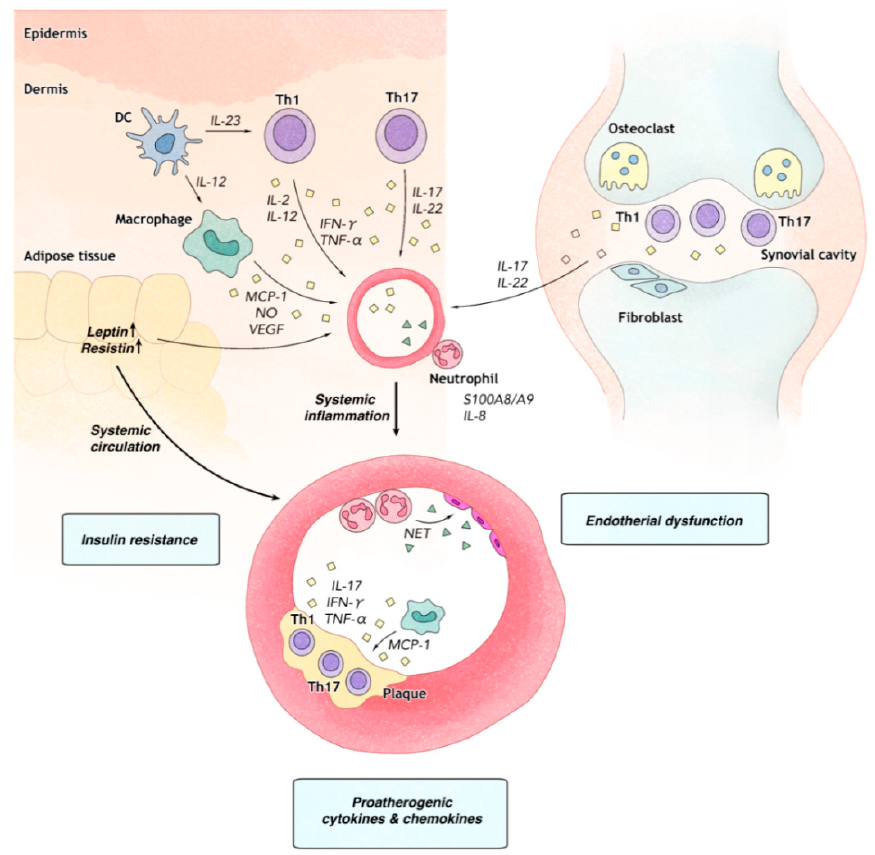
Figure 1. Psoriasis, psoriatic arthritis, and atherosclerosis have the common underlying pathomechanisms. In psoriatic plaque ( left ) and synovial cavity with psoriatic arthritis ( right ), myeloid dendritic cells (DC) stimulate naïve T-cells to di ff erentiate into type 1 helper T (Th1) and type 17 helper T (Th17) cell subtypes. Th1 cells secrete tumor necrosis factor- α (TNF- α ) and interferon gamma (IFN- γ ), leading to keratinocyte and synovial fibroblast activation. Th17 cells secrete IL-17 and IL-22, which promote proliferation of keratinocytes and synovial fibroblasts and angiogenesis. Macrophages cooperates with Th1- and Th17-mediated inflammation by releasing monocyte chemoattractant protein (MCP-1), nitric oxide (NO), and vascular endothelial growth factor (VEGF), which further contribute to angiogenesis. Neutrophil-derived S100A8 / A9 and IL-8 accelerates vascular inflammation. In atherosclerotic plaque ( bottom ), Th1 cells secrete TNF- α and IFN- γ , leading to endothelial activation and promote atherosclerosis. Leptin and resistin produced in adipose tissue enters into systemic circulation and promotes endothelial dysfunction, insulin resistance, and formation of atherosclerotic plaque. Recruitment of neutrophils on the plaque release neutrophil extracellular traps (NETs), which subsequently induces endothelial dysfunction and rupture of plaque. Macrophage-released MCP-1 synergistically promotes the formation of atherosclerotic plaque along with other pro-atherogenic cytokines in patients with psoriasis and psoriatic